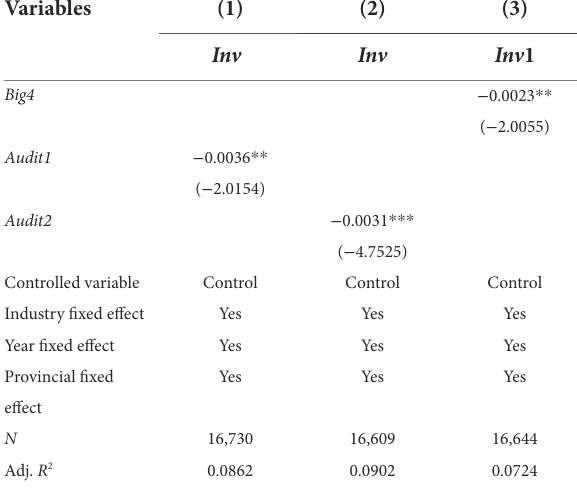
TABLE 8 Robust tests.